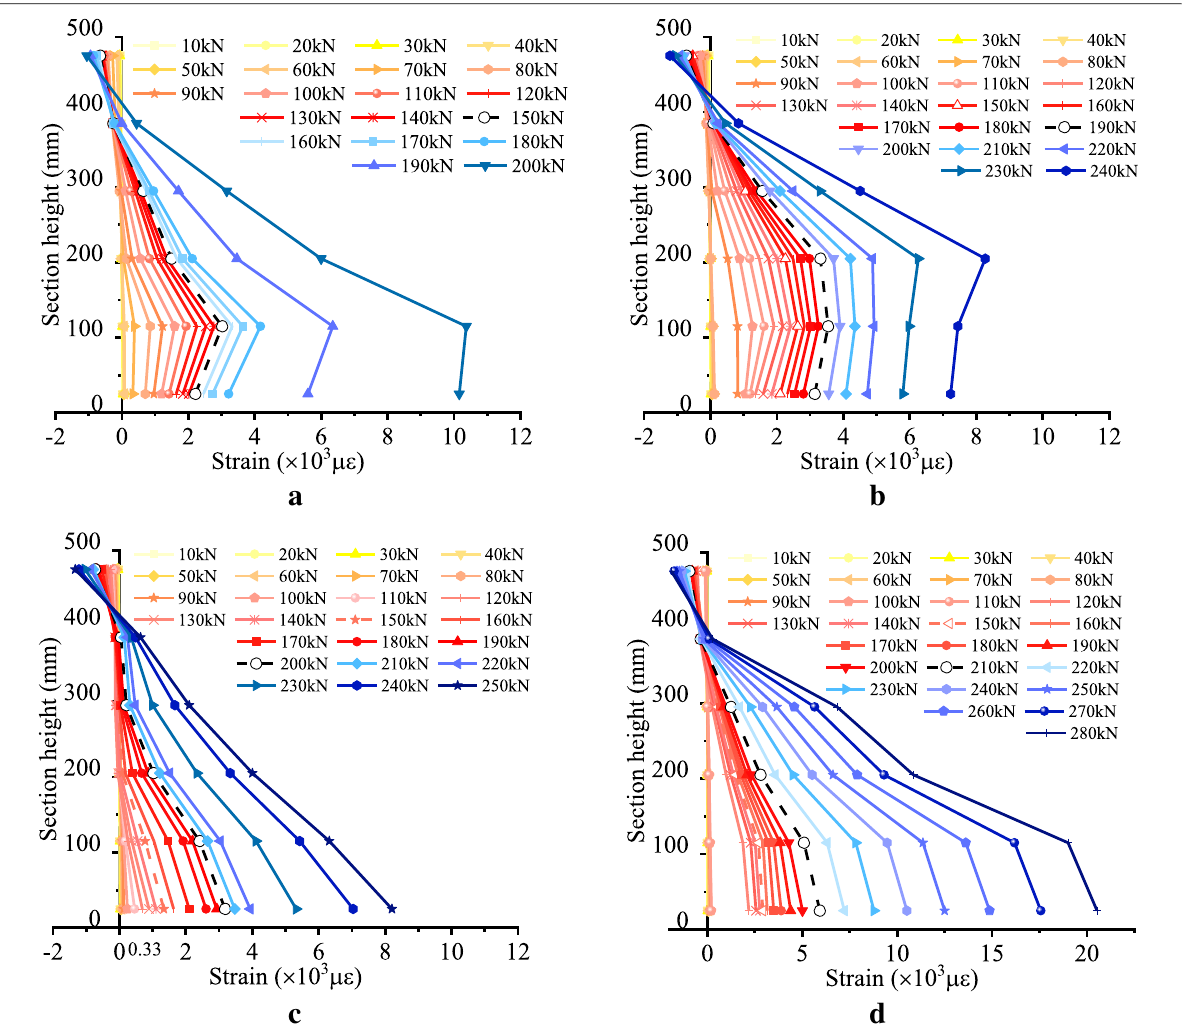
Fig. 12 Location-strain curves of RC beams’ mid-span cross section with different concrete strength: a location-strain curves of the contrast beam (B1); b location-strain curves of CFRP-strengthened beam B2; c location-strain curves of CFRP-strengthened beam B3; d location-strain curves of CFRP-strengthened beam